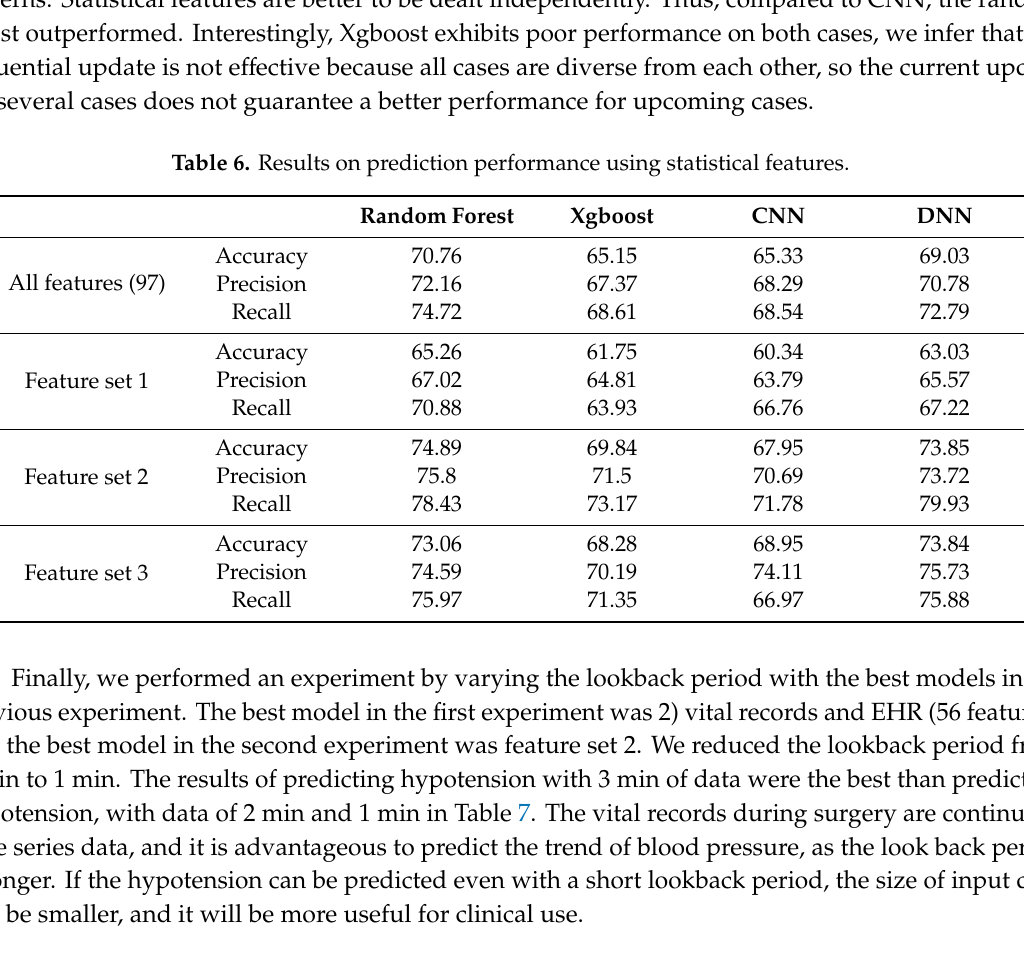
Table 7. Results on prediction performance with di ff erent lookback